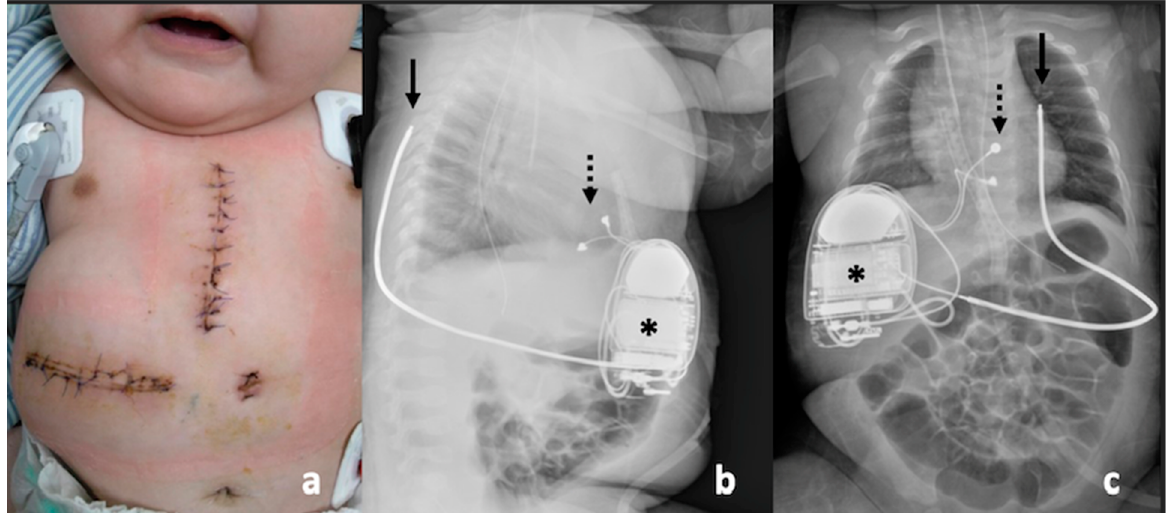
Figure 5. ( a ) Photo showing the postoperative wound after ICD implantation. ( b ) Chest X-ray, lateral view. The generator (asterisk) was implanted in a pocket in the right posterior rectus sheath. The subcutaneous defibrillator coil was located in the left subscapular position (arrow). The bipolar epicardial pacing leads (dotted arrow) were placed on the surface of the right ventricle. ( c ) Chest X-ray, anteroposterior view.